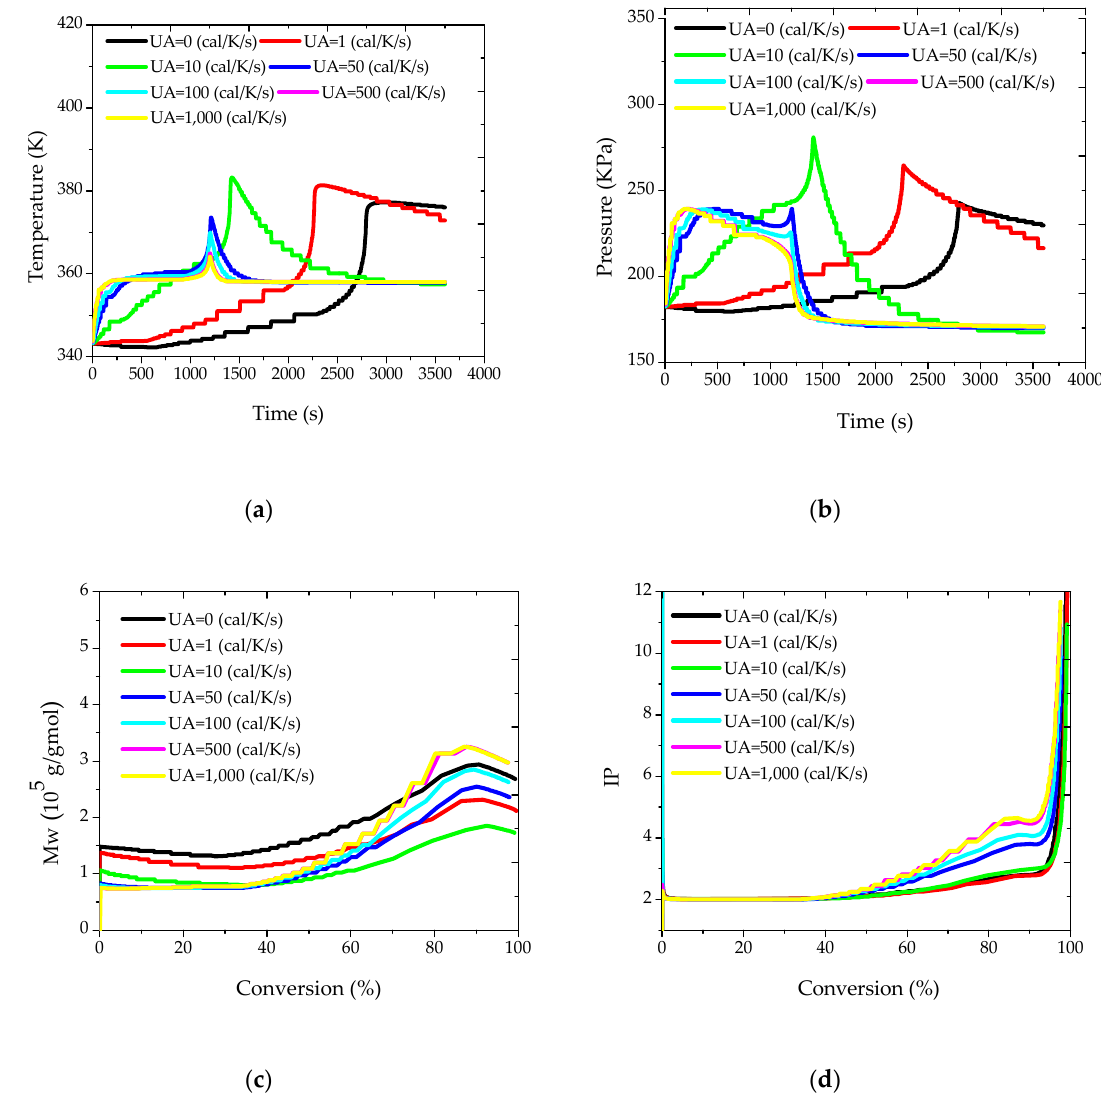
Figure 2. ( a ) Temperature; ( b ) pressure; ( c ) weight ‐ average molar mass (Mw); and ( d ) polydispersity index (IP) profiles for different values of the overall heat transfer coefficient. index (IP) profiles for different values of the overall heat transfer